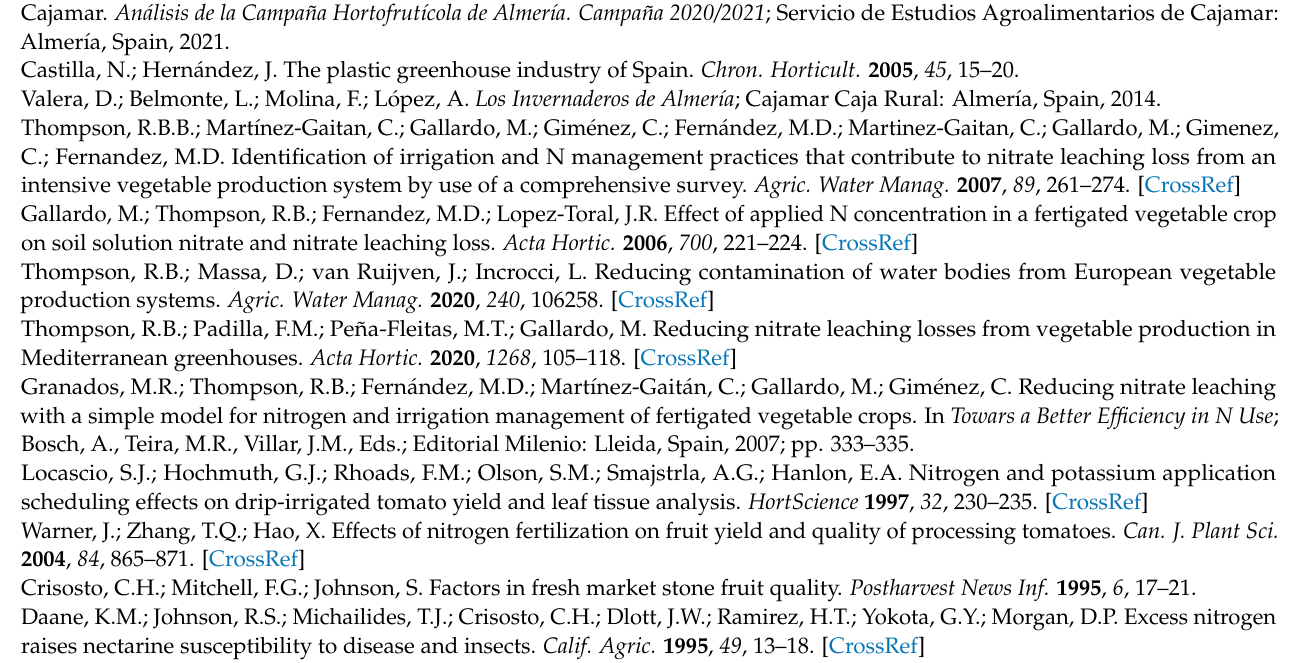
discard; Figure S2: fruit equatorial diameter; Figure S3: fruit polar diameter; Figure S4: fruit hue angle (h); Figure S5: fruit chroma (C*); Figure S6: fruit colour index (IC*); Table S1: results of analysis of variance of yield and percentage discard fruit; Table S2: results of analysis of variance of fruit firmness and TSS; Table S3: results of analysis of variance of fruit weight and equatorial and polar fruit diameters; Table S4: results of analysis of variance of internal fruit